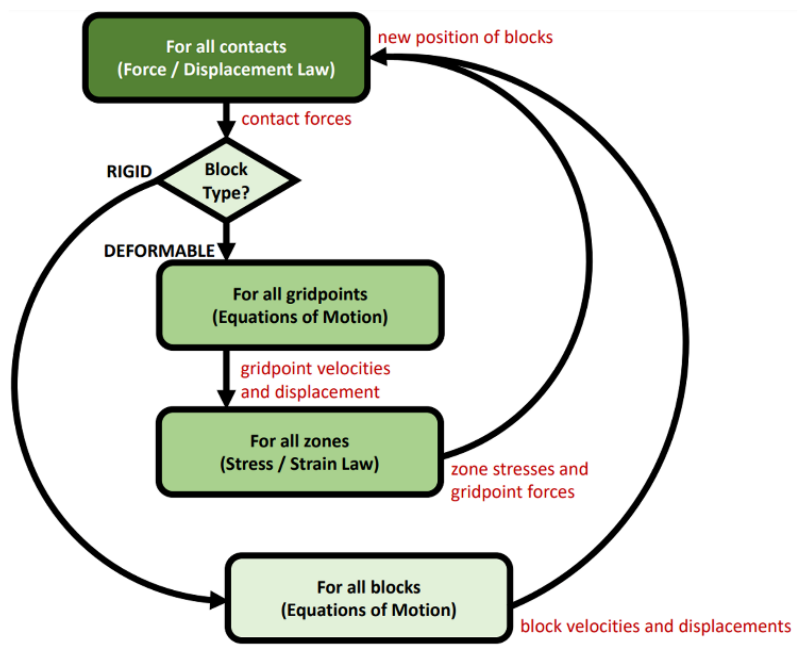
Figure 9. Schematic flow representing the numerical calculation steps in UDEC © (from [71]), adapted with permission from Ref. [71]. Itasca Consulting Group, Inc. (2014) .